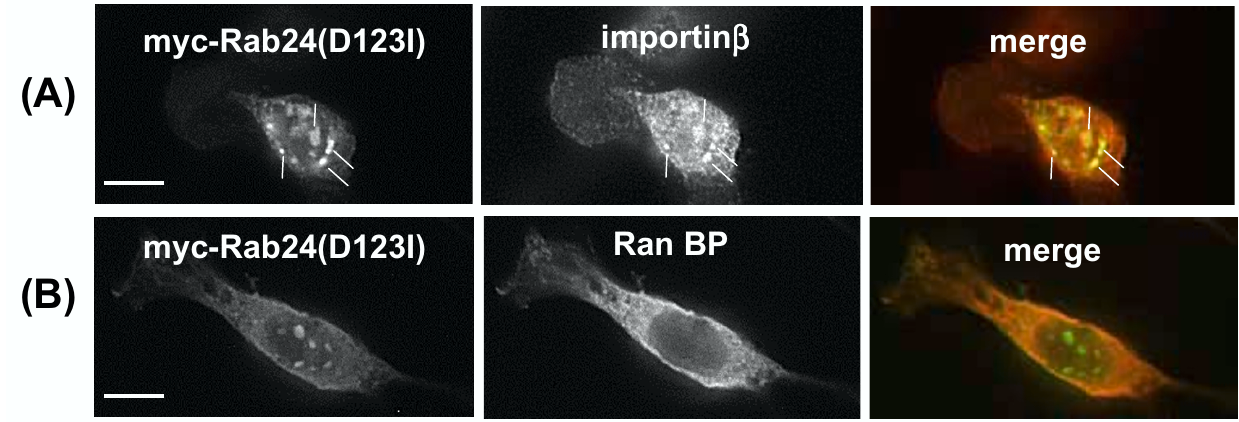
Figure 7 Inclusions generated by Rab24(D123) contain importin- (cid:1) , but not Ran binding protein. (A) mycRab24(D123I) expressed in transfected NIH 3T3 cells was detected with rabbit antibody against the myc epitope followed by FITC-conju- gated GAR IgG. Importin- (cid:1) was detected with mouse monoclonal antibody followed by rhodamine-conjugated GAM IgG. The lines point to aggregates staining for both myc and importin- (cid:1) . (B) mycRab24(D123I) was detected as in A, and Ran BP was detected with a monoclonal antibody, followed by rhodamine-conjugated GAM IgG. The scale bars represent 10